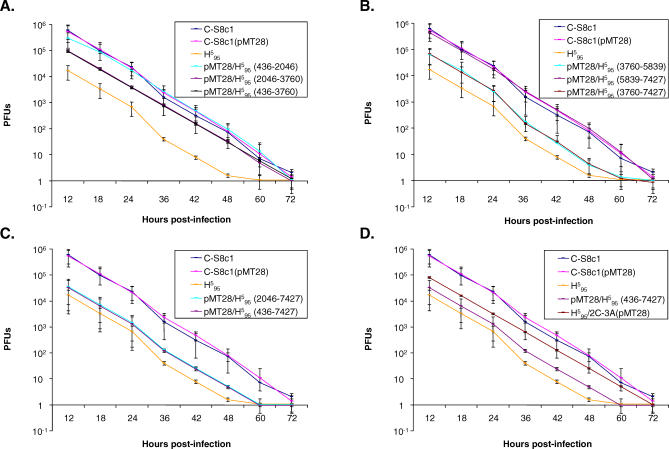
Killing of BHK-21 Cells by Recombinant FMDV ChimerasTime needed to kill 104 BHK-21 cells as a function of the initial PFU of the following viruses:(A) C-S8c1, C-S8c1(pMT28),
, pMT28/
(436-2046), pMT28/
(2046–3760), and pMT28/
(436-3760).
(B) C-S8c1(pMT28),
, pMT28/
(3760–5839), pMT28/
(5839–7427), and pMT28/
(3760–7427).
(C) C-S8c1(pMT28),
, pMT28/
(2046–7427), and pMT28/
(436-7427).
(D) C-S8c1(pMT28),
, pMT28/
(436-7427), and
/2C-3A(pMT28).
Each value represents the mean and standard deviation from triplicate assays. The viruses analyzed are described in Materials and Methods; C-S8c1(pMT28) is C-S8c1 expressed as an infectious transcript and rescued by cell transfection. Virulence values are given in Tables 2 and S1.